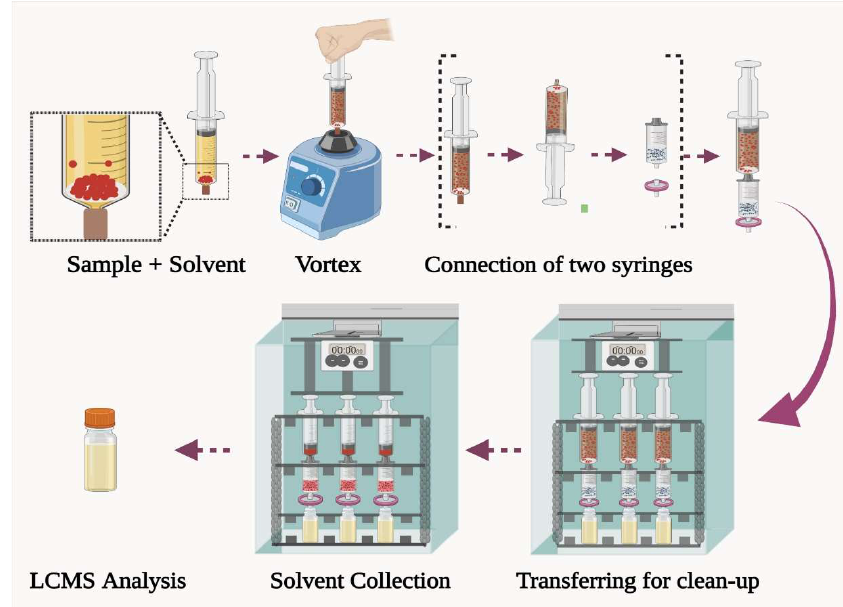
Figure 6. Graphical representation of FaMEx extraction